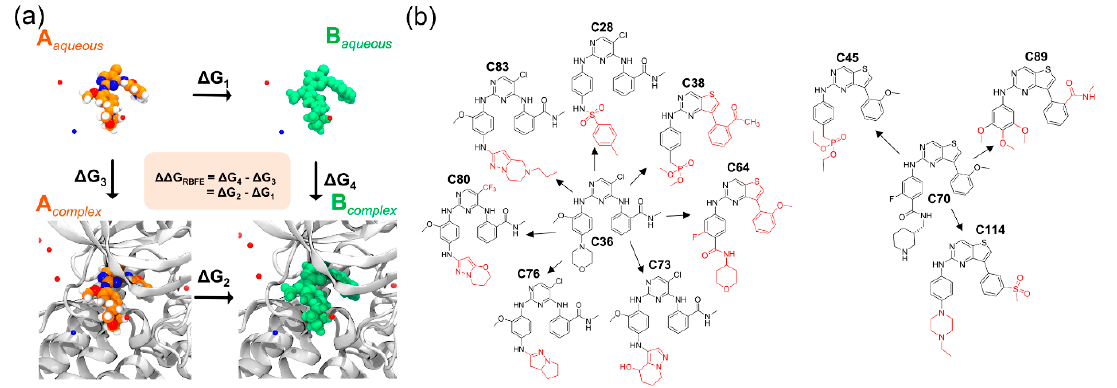
Figure 4. Overview of the FEP scheme and relative binding affinity estimation. ( a ) Thermodynamic pathway of ligand transformation from state-A to state-B in aqueous and complex form. The ∆∆ G A → B can be deduced from the free energy changes of both states in aqueous and complex systems. ( b ) Relative binding energy calculation of the ligands through alchemical transformation. The mismatched atoms between the ligand pairs, which need to be perturbed, are shown in red.